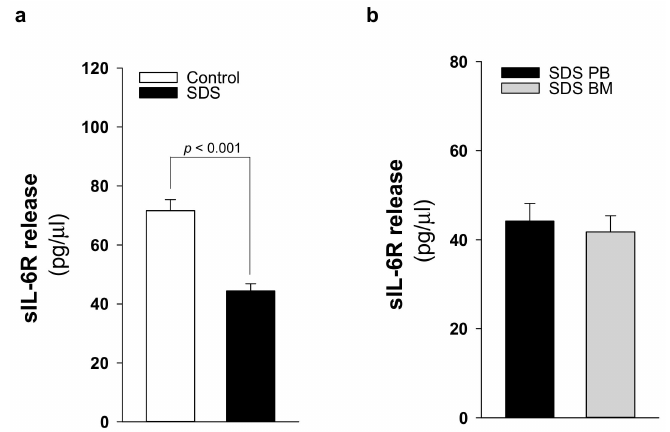
Figure 6. sIL6-R release is reduced in patients with SDS. ( a ) sIL-6R protein release was quantified by ELISA in PB plasma samples obtained from 21 patients with SDS (UPN 1, 13, 26, 37, 47, 52, 56, 57, 58, 63, 65, 66, 69, 72, 73, 74, 87, 94, 104, 106, 108) compared with age-matched plasma controls. ( b ) sIL-6R concentration in BM plasma samples obtained from eight patients with SDS (UPN 47, 56, 65, 74, 87, 94, 106, 108) compared with PB plasma samples obtained from the same patients. Normal distribution was tested by the Shapiro–Wilk test. The Mann–Whitney Rank Sum Test was calculated and reported within